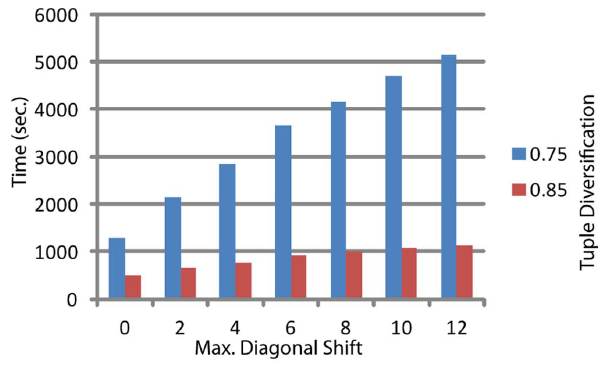
Figure 9. PSimScan processing time dependence on maximum diagonal shift. Streptococcus pneumoniae R6 proteome was used as the query set, SwissProt/Uniprot database – as the subject set. Measurements were taken at kthresh : 15 and approx: 0.75 and 0.85.